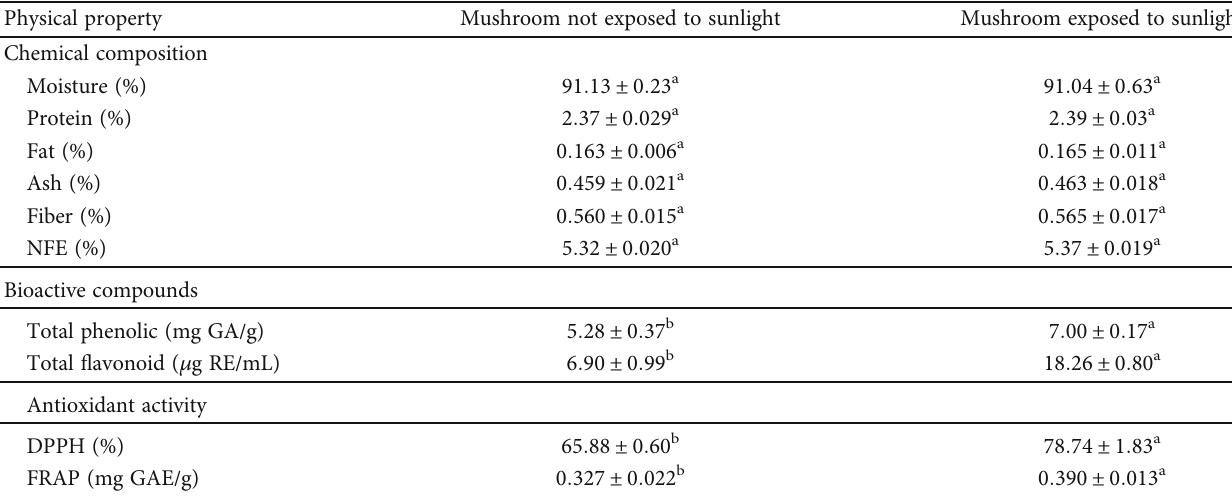
Table 3: Chemical composition, bioactive compounds, and antioxidant activity of fresh oyster mushroom (not exposed) and exposed to sunlight for